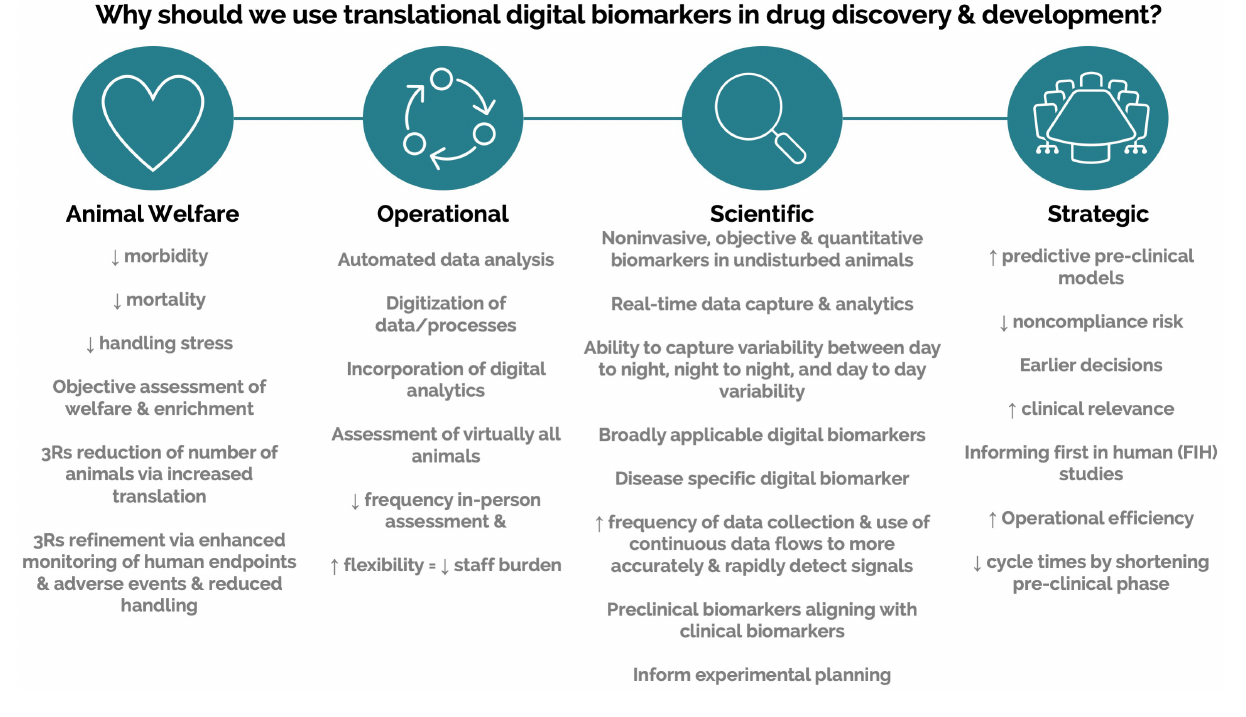
FIGURE 4 | Value propositions for translational digital biomarkers within drug discovery and